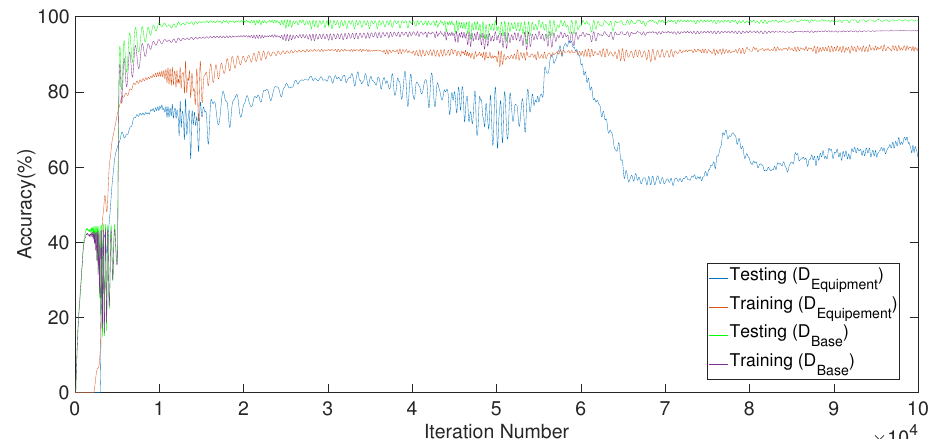
Figure 3. Training and testing accuracy of DNN predicting combined performance metrics for Dataset Base and Dataset Equipment during training phase.